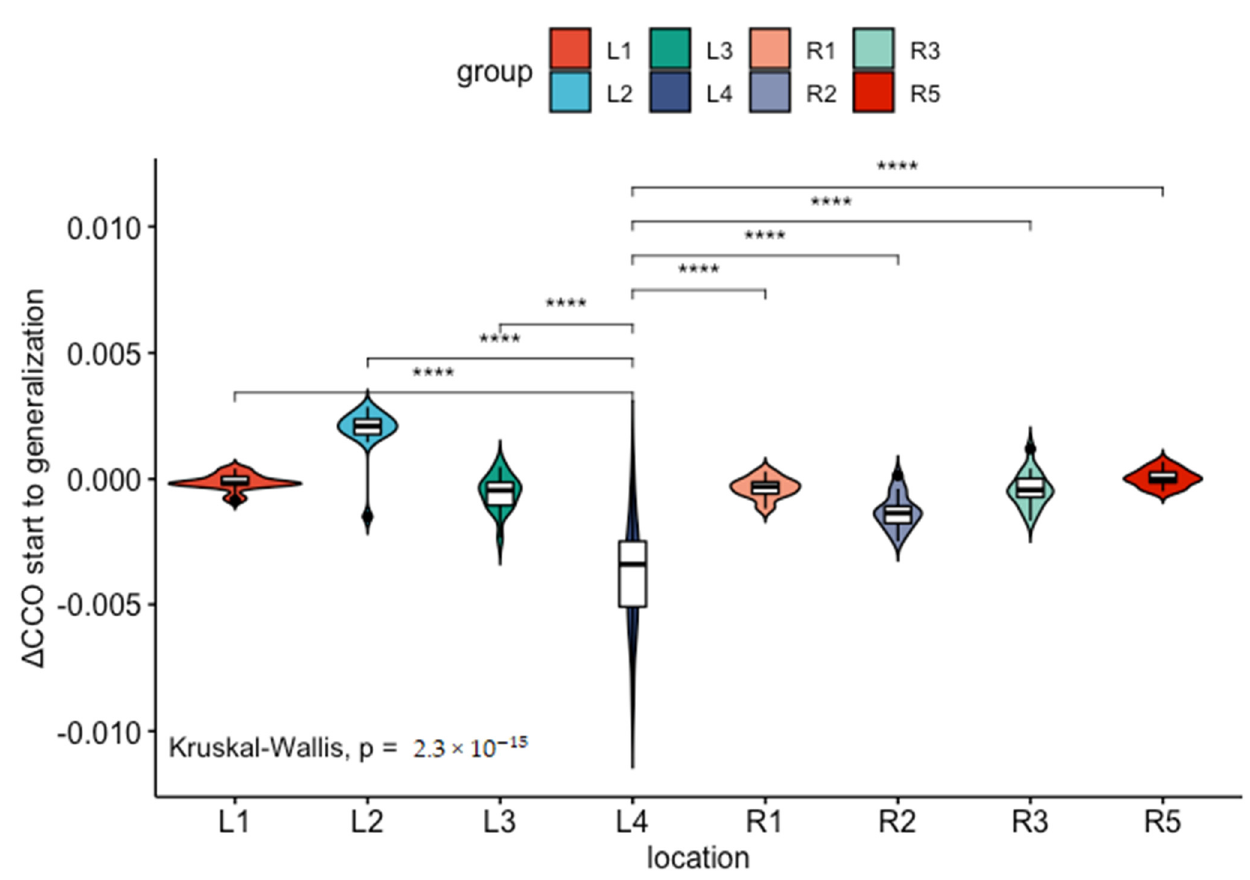
Figure 3. The drop in ( ∆ [oxCCO]) (measured in mmol) from seizure start to seizure generalization is significantly higher (****) at location L4 compared to all other channels.